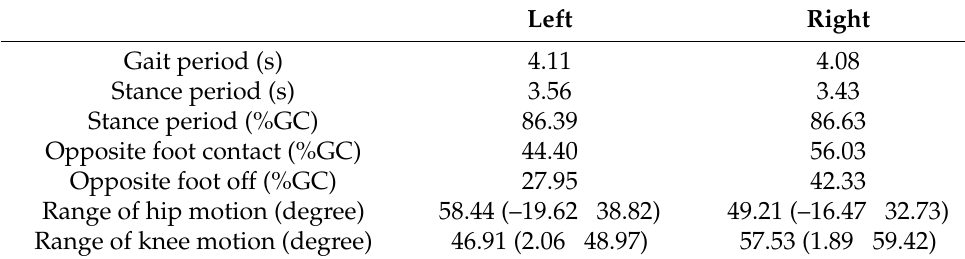
Table 2. Gait parameters of walker gait wearing a torque-controlled